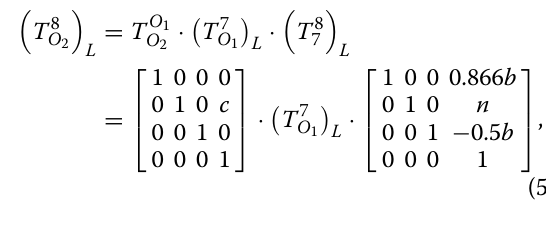
Similarly, the poses of the end effector tip from the global frame {O 2 } along the left and right legs are given in Eqs. (5) and (6) respectively: